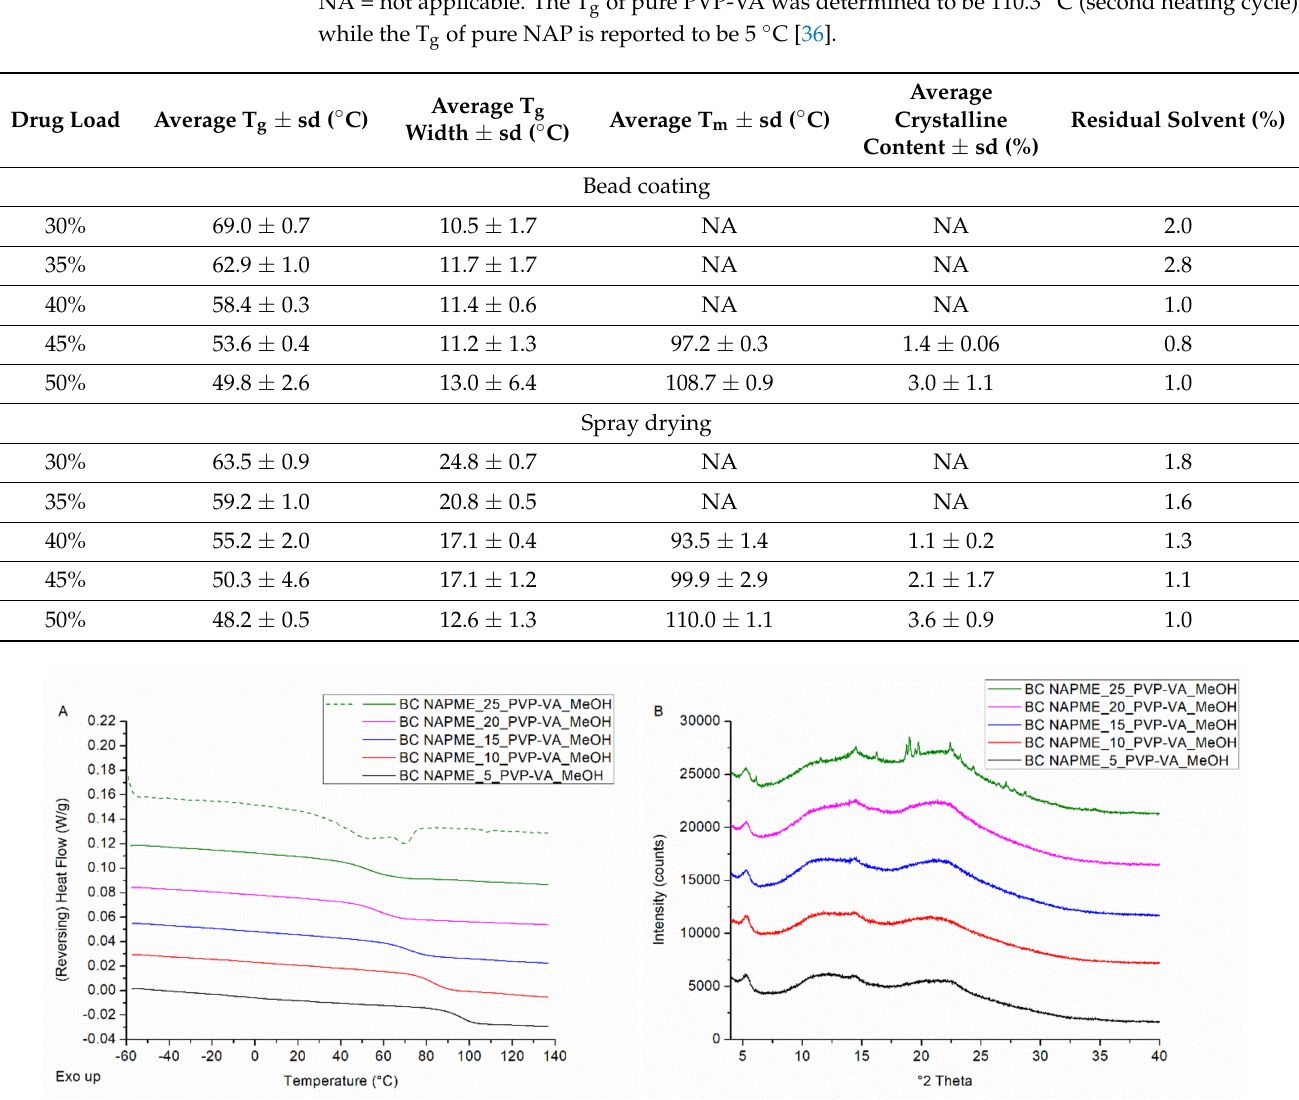
Figure 6. ( A ) mDSC thermograms of milled NAPME–PVP-VA-coated beads (BC), with drug loadings from 5% (black) to 25% (green) by intermediate steps of 5%. The THF (dashed) and RHF (solid) signals are shown as arbitrary units. ( B ) Corresponding XRPD diffractograms. The intensities are shown as arbitrary